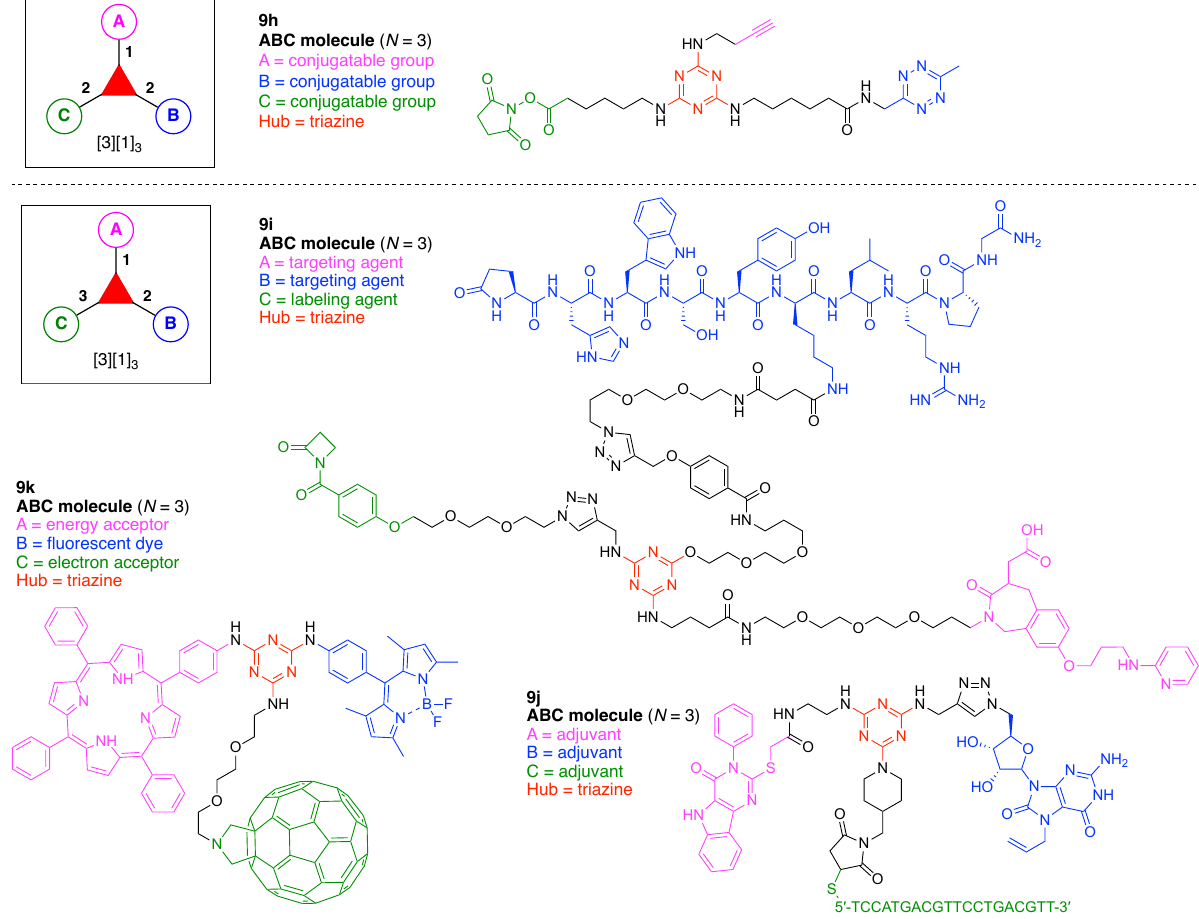
Figure 37. Examples wherein each contains a single triazine hub with ABC substituents. A β -lactam equipped bifunctional targeting module ( 9i ) was developed for irreversible chemical programming of monoclonal aldolase antibody 38C2 (Figure 37) [231]. The module is composed of a triazine hub and three functional units: (A) an integrin inhibitor SCS-873 to target integrin; (B) luteinizing hormone releasing hormone (LHRH) containing a D-Lys 6 modification to target a LHRH receptor, and (C) a β -lactam for covalent labeling of monoclonal antibody 38C2. This construct ( 9i ) has composition ABC and architecture [3][1] 3 . Toll-like receptor (TLR) agonists are used as adjuvants with antigens to control immune responses [232,233]. The covalent juxtaposition of three TLR agonists ( 9j ) was constructed to serve as a novel vaccine adjuvant (Figure 37) [234]. The tri-agonist is composed of a triazine hub and three functional units: (A) a TLR4 agonist pyrimido[5,4- b ]indole; (B) a TLR7 agonist loxoribine, and (C) a TLR9 agonist CpG-ODN1826. This construct ( 9j ) has composition ABC and architecture [3][1] 3 .